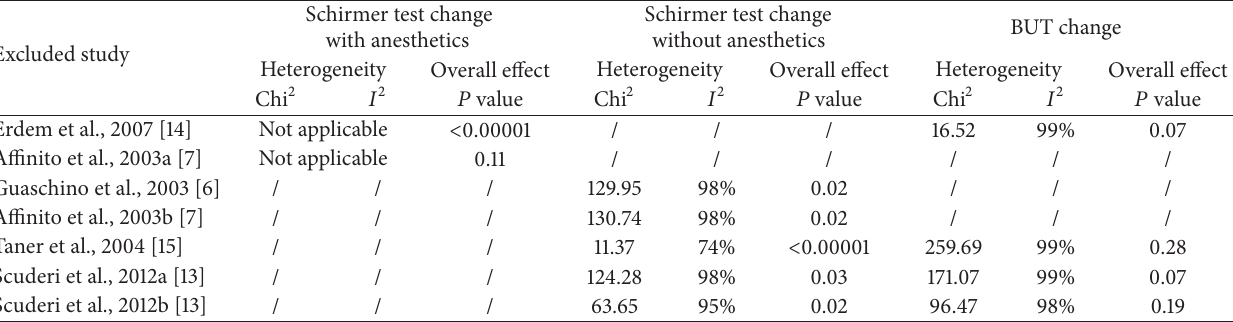
Table 5: Results of the sensitivity analysis.